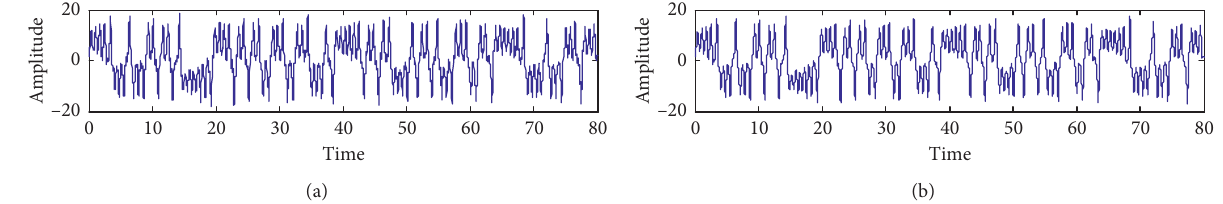
Figure 7: Results of denoising: (a) unsmoothed morphological filtering and (b) smooth morphological filtering.